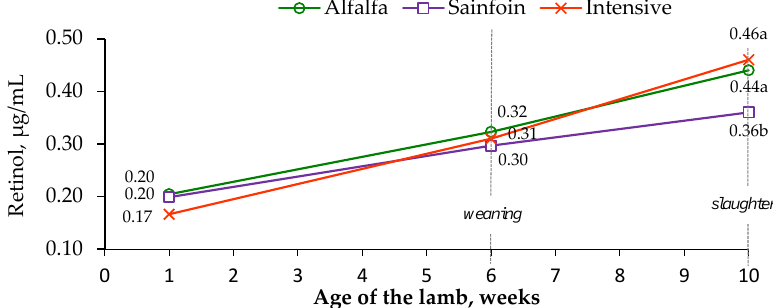
Figure 1. Effect of the maternal feeding on plasma retinol concentrations in lamb. Within an age, means with a different letter differ at p < 0.05.